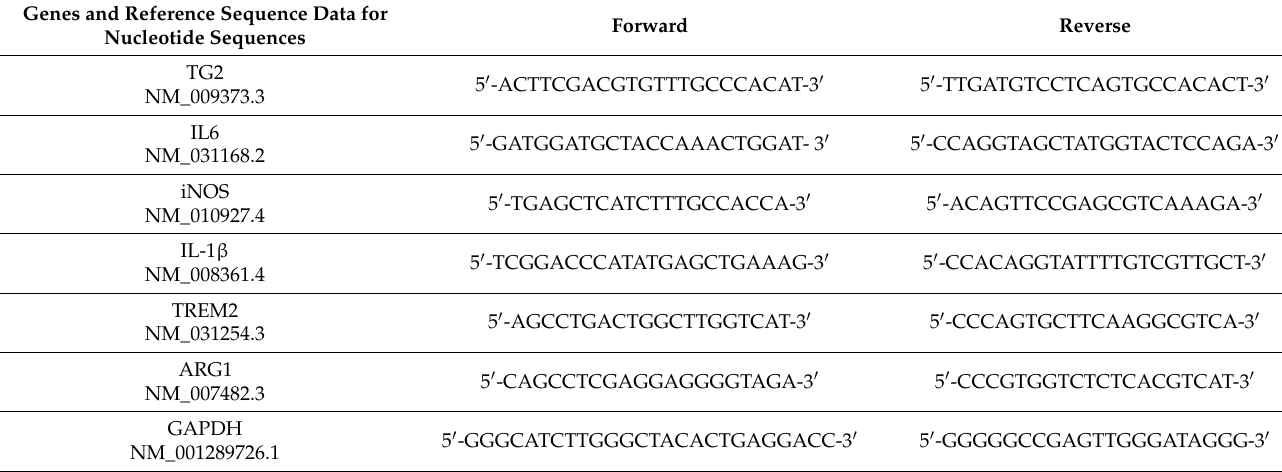
Table 1. List of primers used.